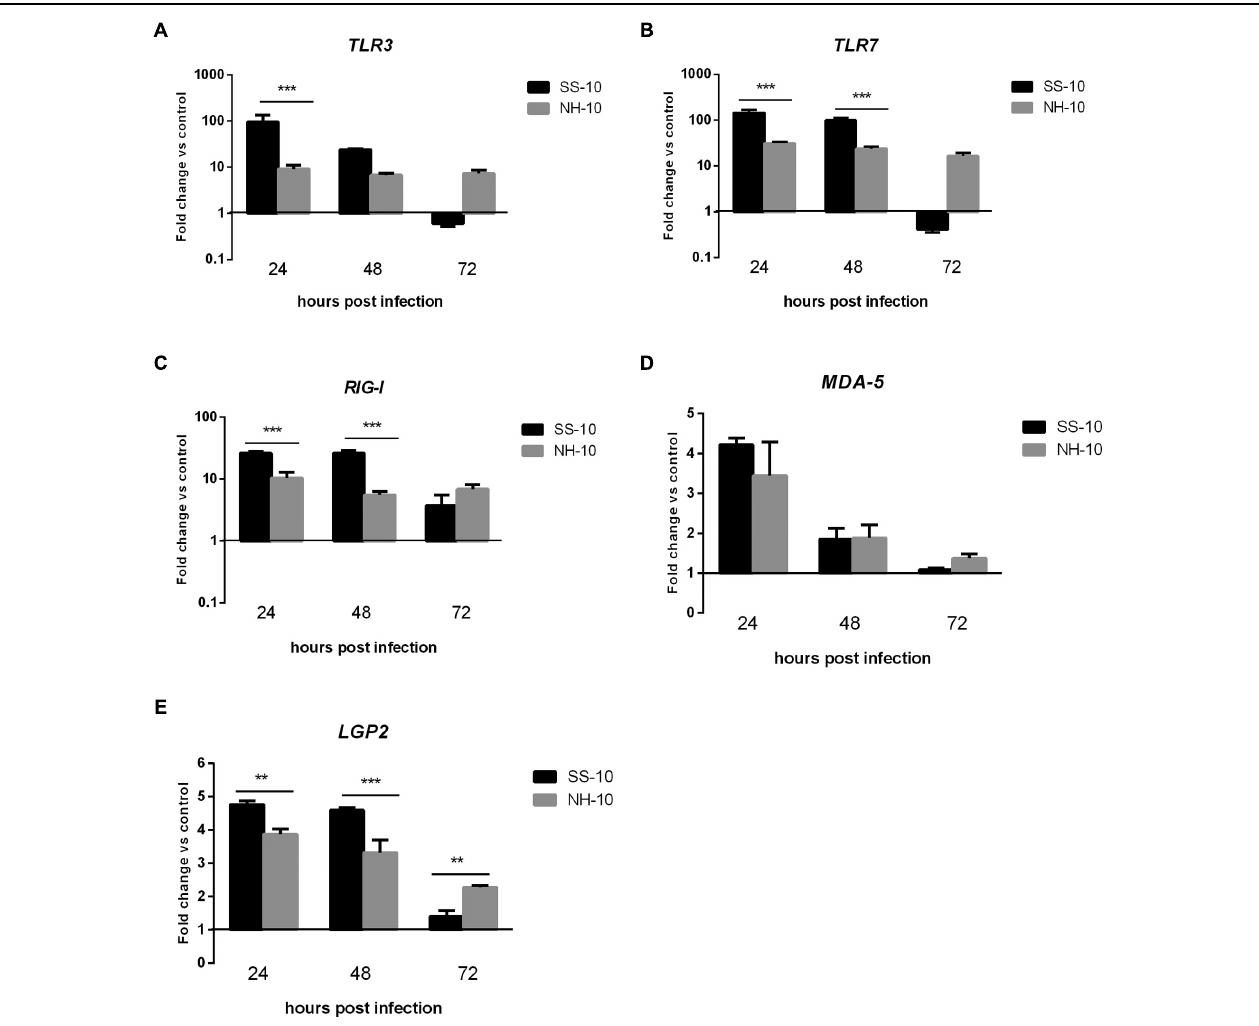
FIGURE 2 | Fold change expression of pattern recognition receptors (PRRs) in the lungs of infected ducks in response to SS-10 and NH-10. (A) TLR3 , (B) TLR7 , (C) RIG-I , (D) MDA5 , (E) LGP2 . The Y -axis represents the fold change in target gene expression in the experimental group relative to those in the control group and presented as the mean values ± standard deviation ( n = 3). Significance is analyzed with two-way ANOVAs between SS-10 group and NH-10 group at the same time points ( ∗ p < 0.05, ∗∗ p < 0.01, ∗∗∗ p < 0.001). Error bars indicate standard